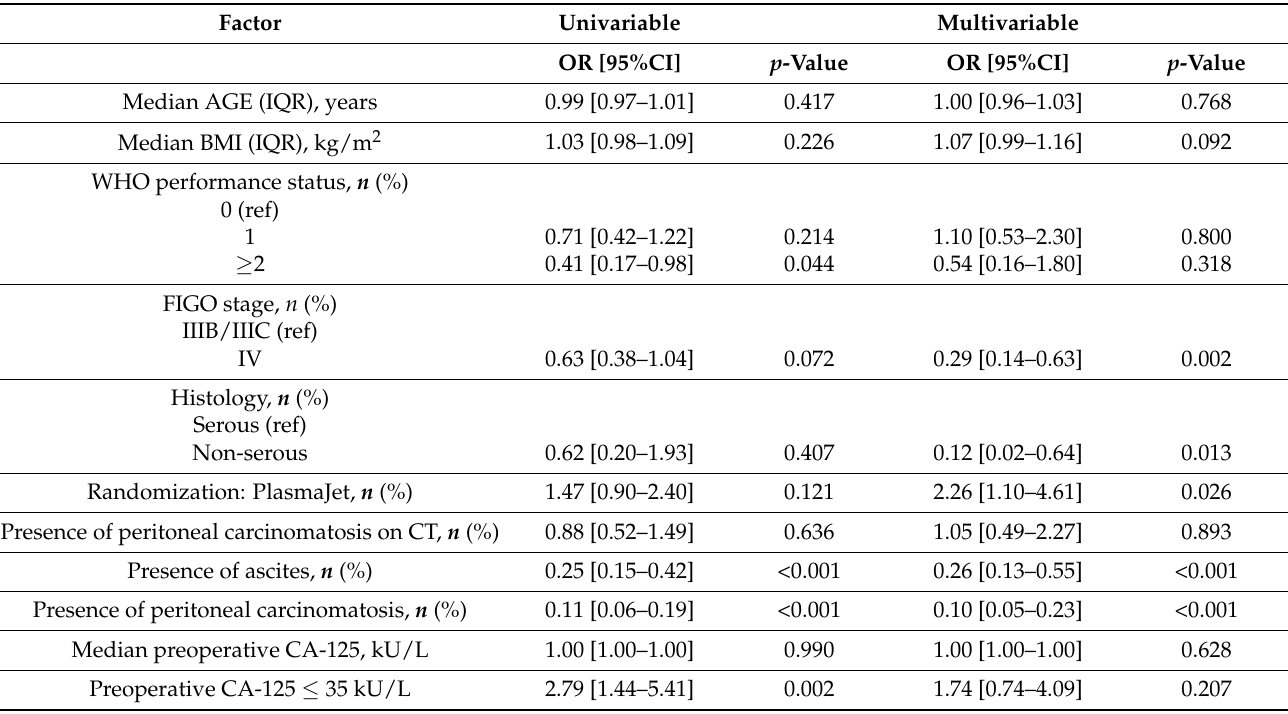
Table 3. Univariable and multivariable analysis of factors predicting complete interval